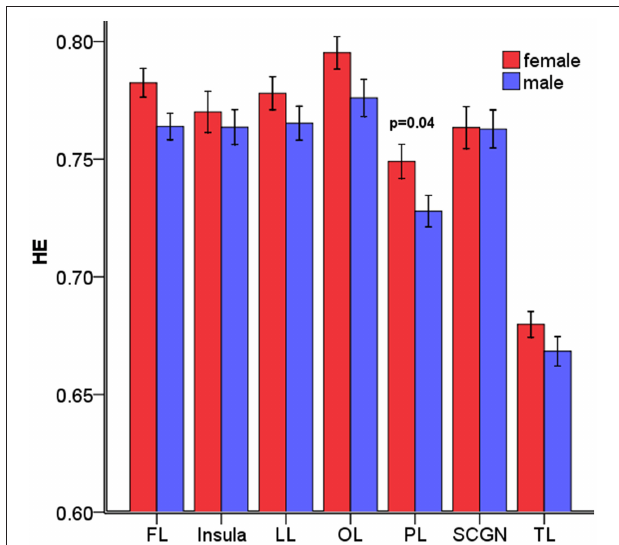
FIGURE 4 | Mean HE of the 7 lobar brain regions between males and females. Significant differences were observed in parietal lobe. Error bar represented standard error. FL, frontal lobe; LL, limbic lobe; OL, occipital lobe; PL, parietal lobe; SCGN, sub cortical gray nuclei; TL, temporal lobe. The p -values were corrected using the FDR method.